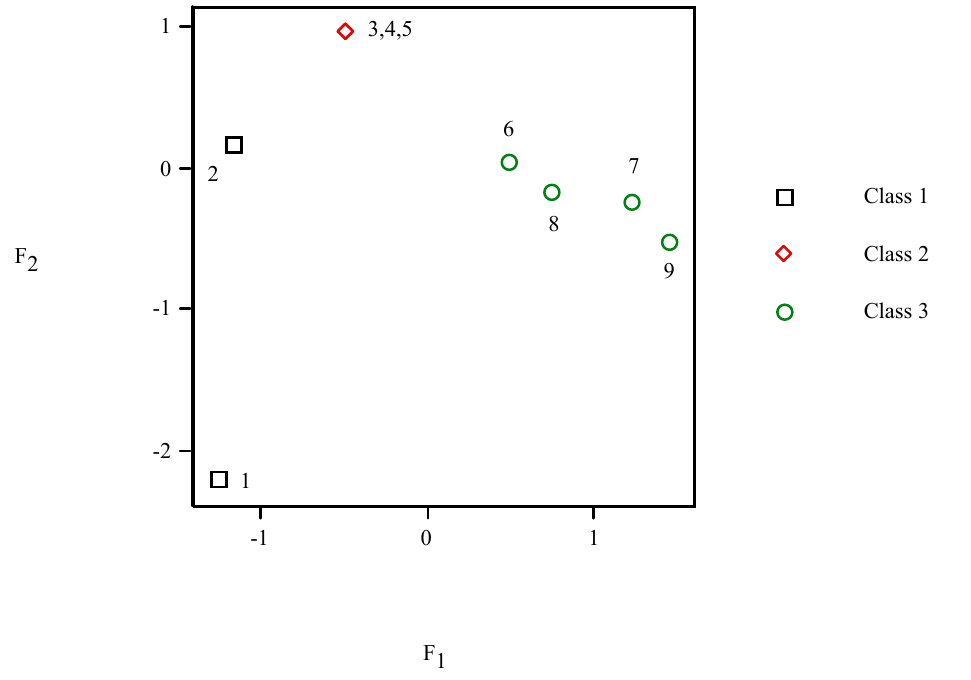
versus F scores plot of the principal component analysis for the Figure 5. F 2 1